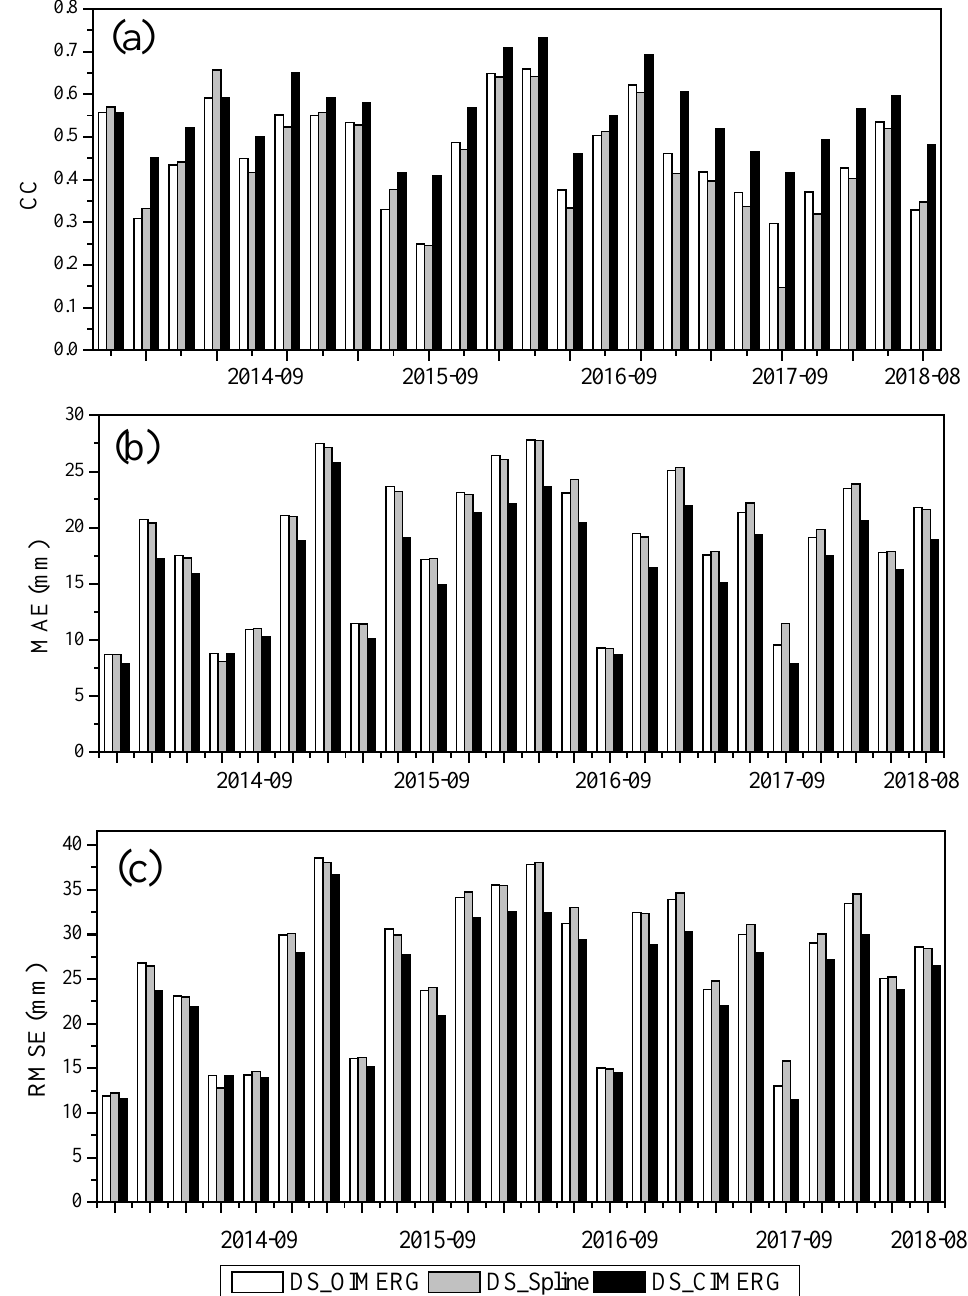
Figure 6. ( a ) The correlation coefficient (CC), ( b ) mean absolute error (MAE), and ( c ) root-mean-square error (RMSE) values of downscaled precipitation estimates obtained using GWR based on OIMERG (DS_OIMERG), GWR based on CIMERG (DS_CIMERG), and spline interpolation (DS_Spline) for the Tianshan Mountains between May and September 2014–2018. Independent rain gauge observations were used as benchmarks.